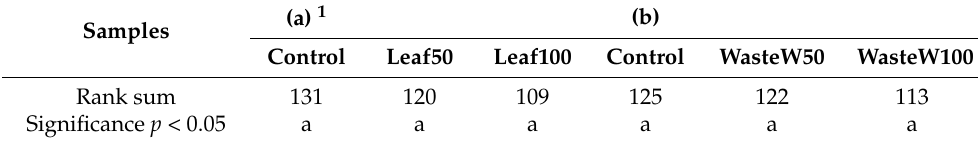
Table 6. Results of the ranking preference tests on the freshly prepared GF breadsticks.